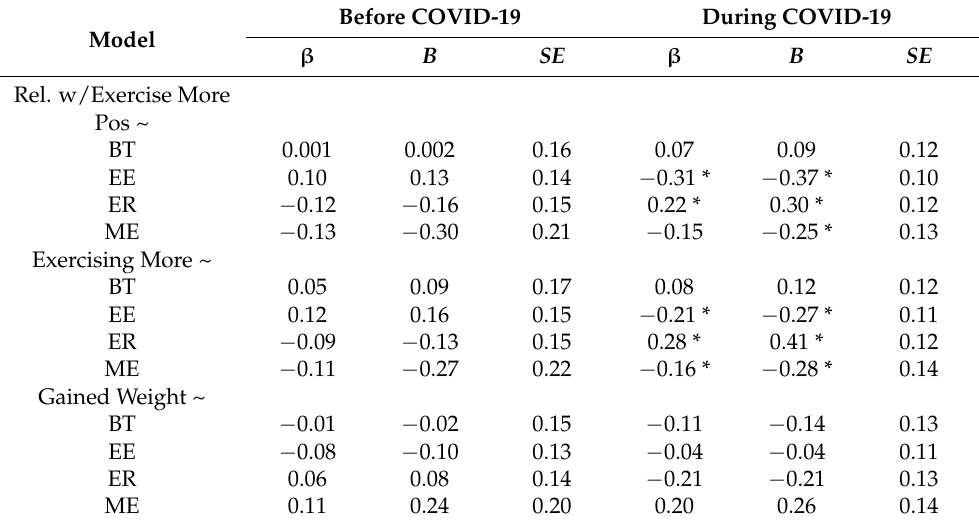
Table 1. Intuitive Exercise Before and During the Pandemic Predicting Exercise Behaviors and Attitudes during